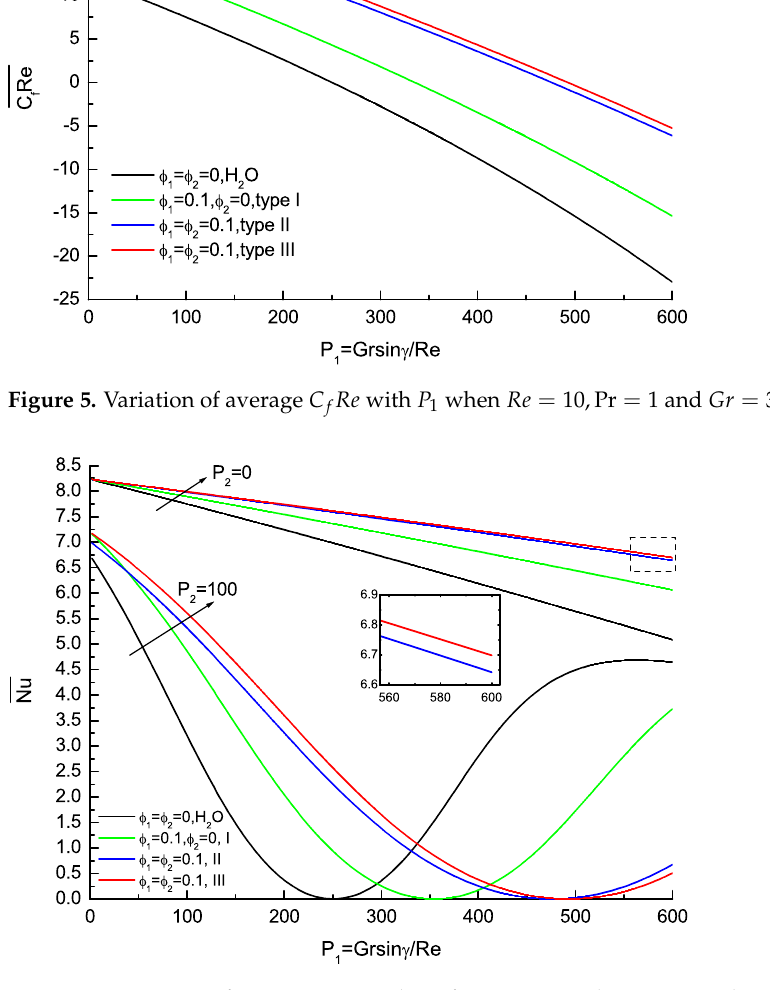
Figure 6. Variation of average Nu with P 1 for P 2 = 0 and P 2 = 100 when Re = 10,Pr = 1 and Gr =